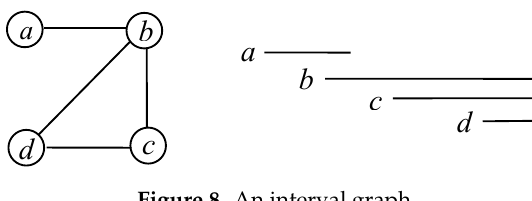
Figure 8. An interval graph.